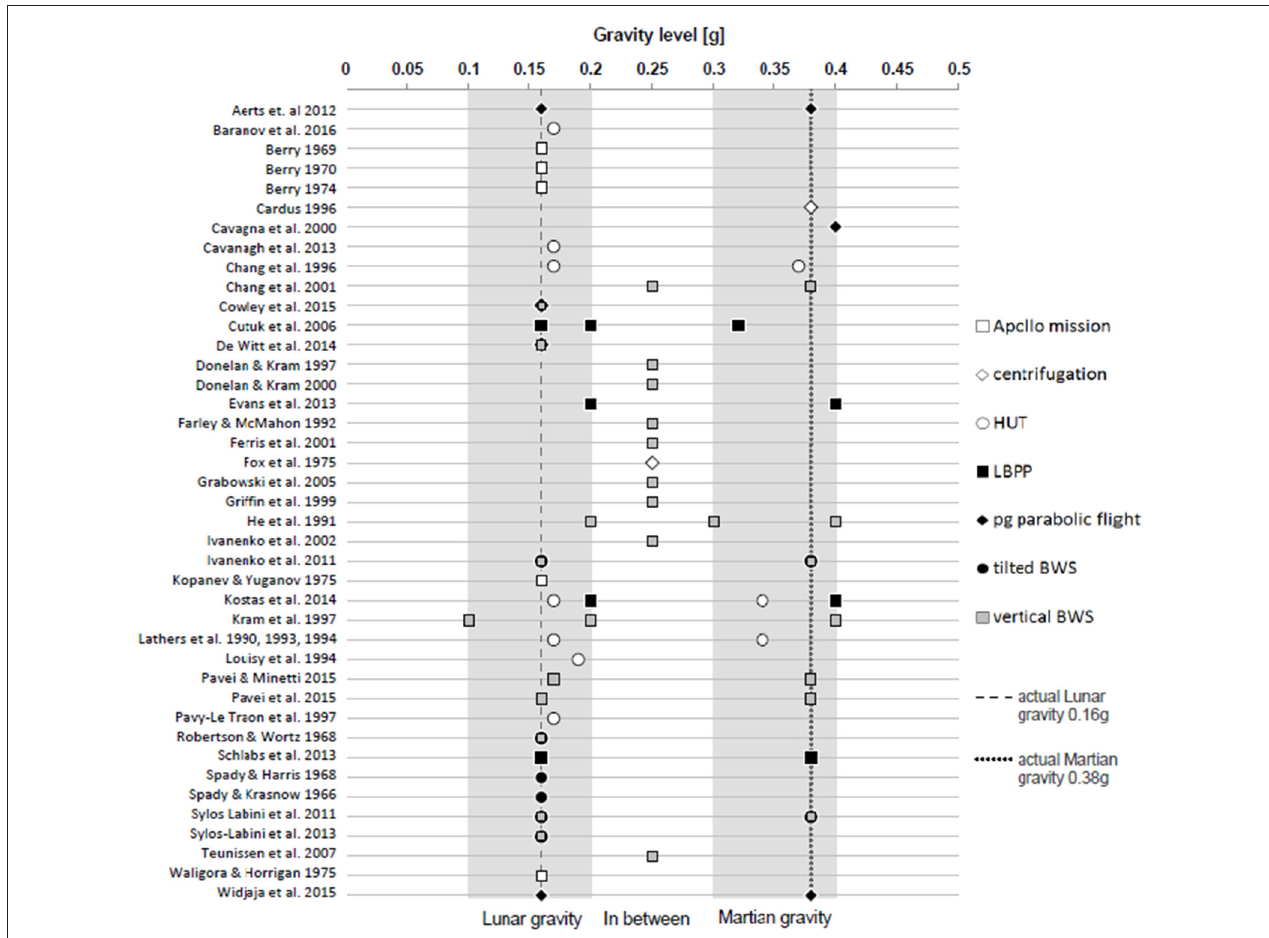
FIGURE 4 | Gravity levels and simulation models of included studies. The ranges that were considered acceptable for Lunar- and Martian gravity in the present review are shown in gray. The exact values for Lunar and Martian gravity are depicted through dashed and dotted lines. Control conditions and measured gravity levels outside the defined range of 0.1–0.4g are not shown. HUT, Head-up tilt; LBPP, Lower body positive pressure; BWS, body weight support system; pg, partial gravity.